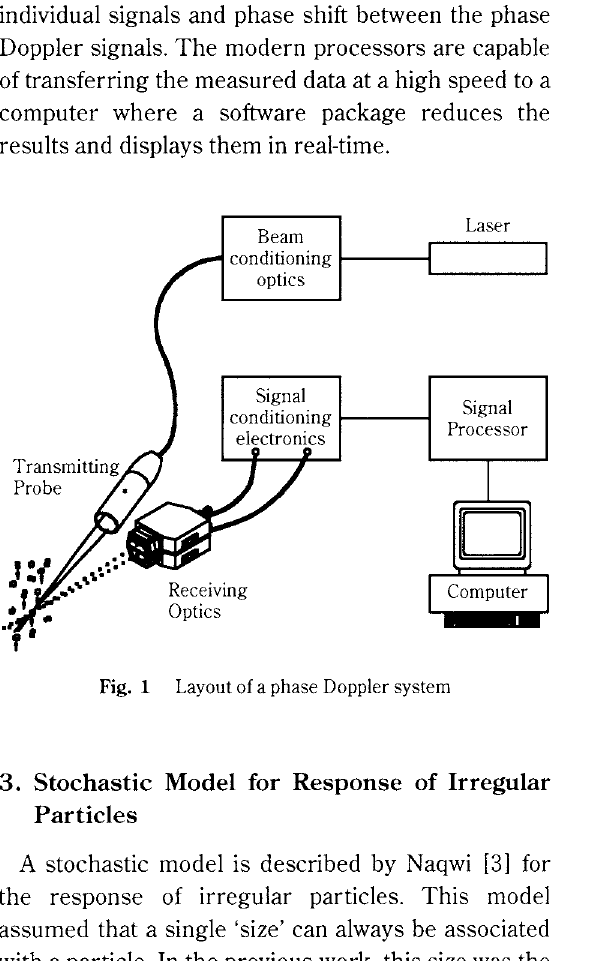
Fig. 1 Layout of a phase Doppler